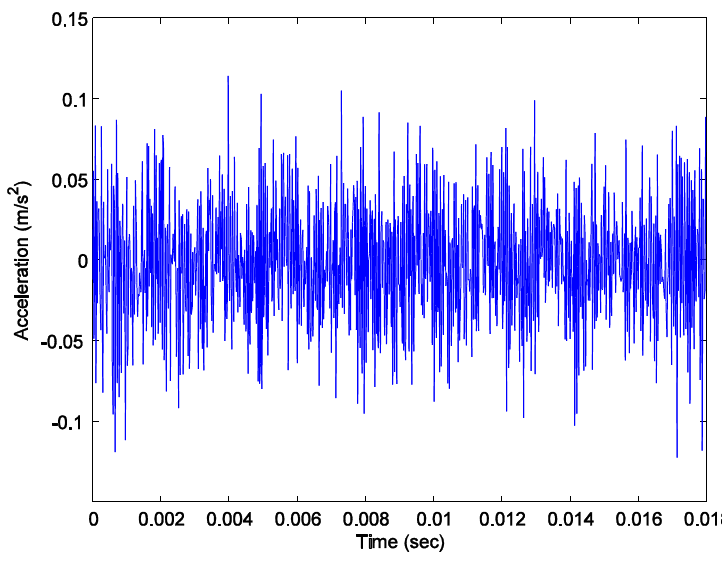
Figure 5. Vibration data points of a roller-bearing with defect (D1).